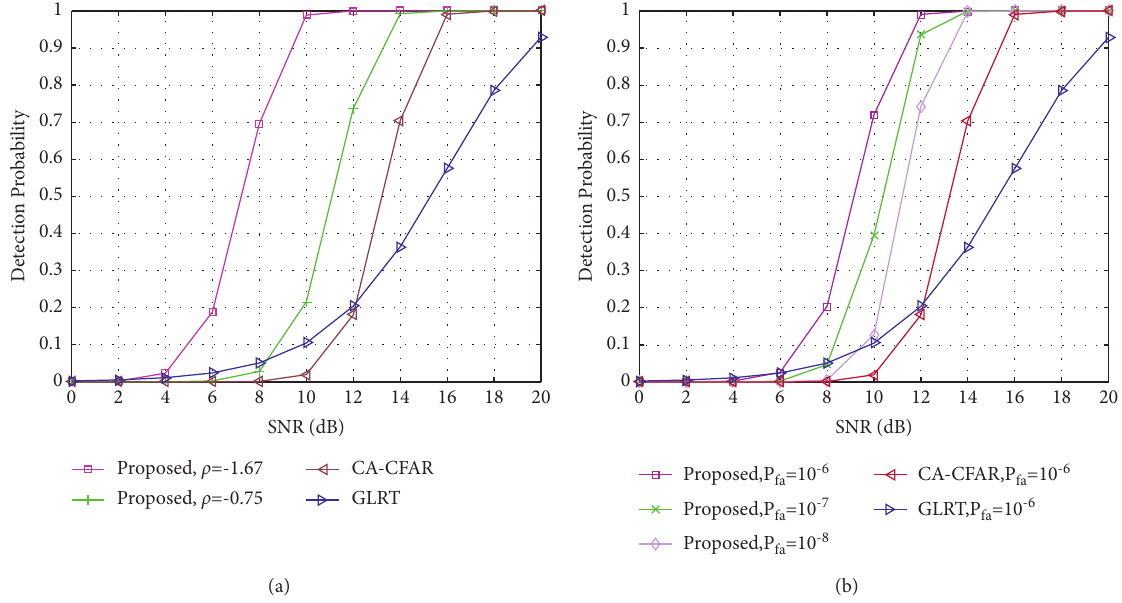
Figure 7: Comparison of detection probability. (a) Detection probability of different ρ , when P different P fa , when ρ � − 1 .